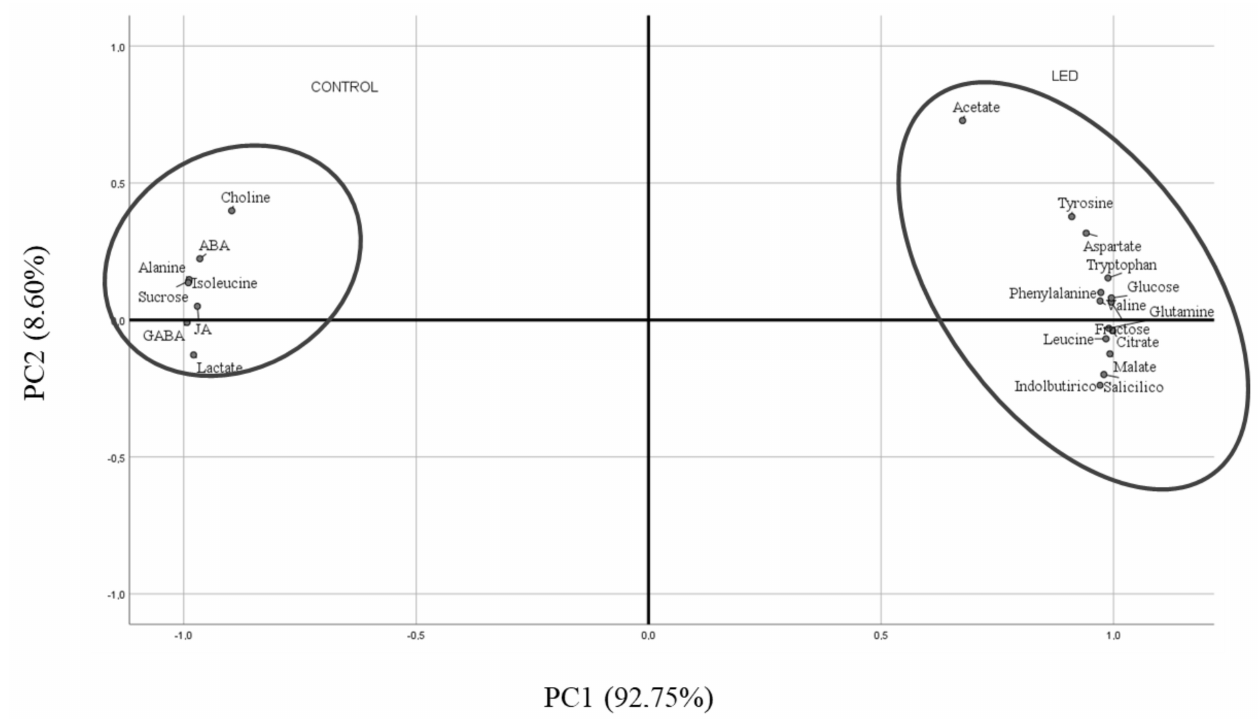
Figure 6. Bi-plot of PC1 viz. PC2 from principal component analysis showing the main metabolites characterising Control (CON, unlighted) and irradiated R LED (LED) pepper